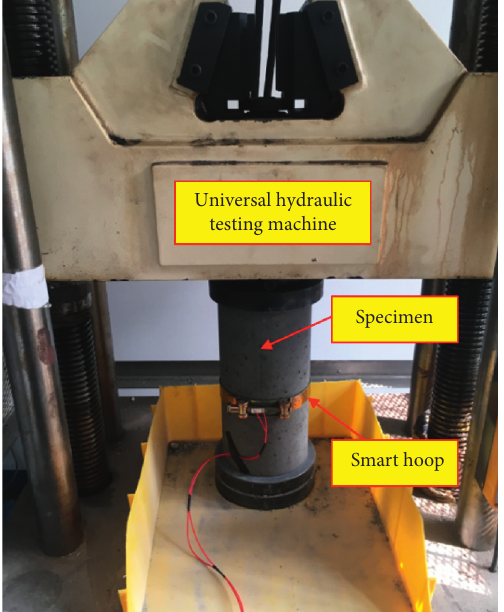
Figure 12: Experimental setup using the universal hydraulic testing